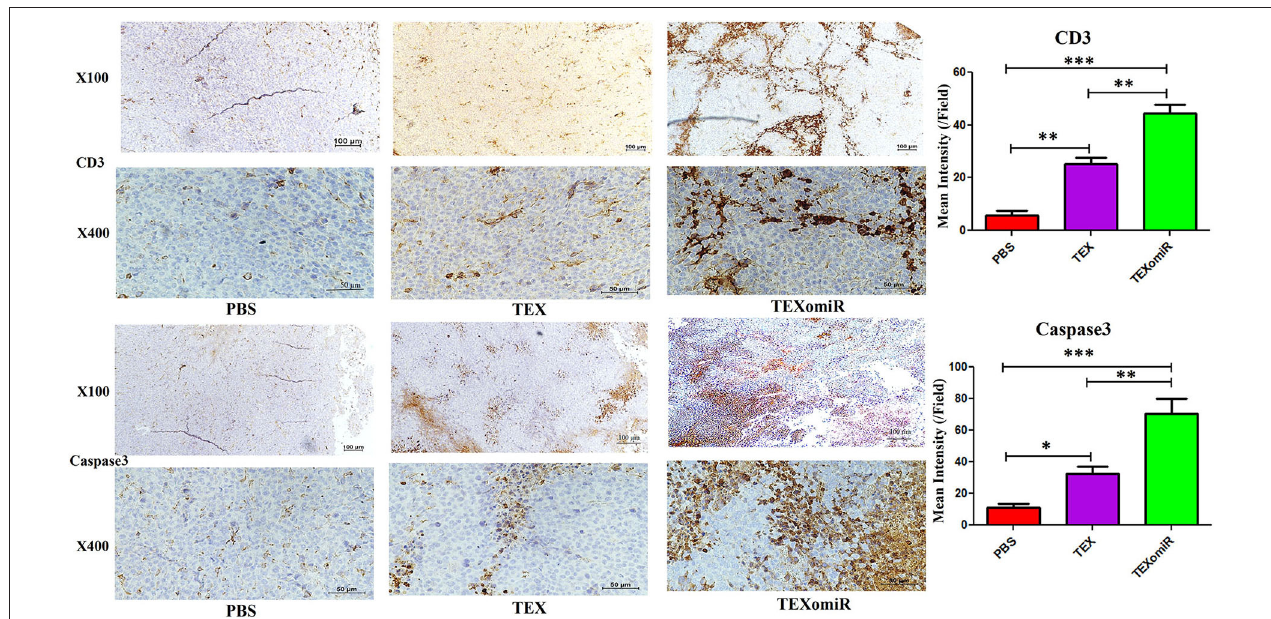
FIGURE 14 | Immunohistochemistry results of the tumor tissues of CT-26 tumor-bearing mice. Treatment with TEXomiR significantly increased tumor-infiltrated lymphocytes compared to the TEX and phosphate-buffered saline (PBS) groups. Microscopic observation also clarifies the high expression of caspase 3 in the tumor sections of TEXomiR-treated mice. The TEXomiR-treated group significantly showed a higher mean intensity of CD3 and caspase 3 compared to the TEX and PBS groups. While the immunoreactivity of CD3 and caspase 3 in the TEXomiR group was diffuse, the TEX and PBS groups represented a scattered pattern. The images were quantified by Image J software (NIH, USA). The data are presented as mean ± SD. * P < 0.05, ** P < 0.01, *** P < 0.001. One-way ANOVA was used to make comparisons between groups. TEXomiR, miR-124-3p-enriched TEXs; TEX, tumor